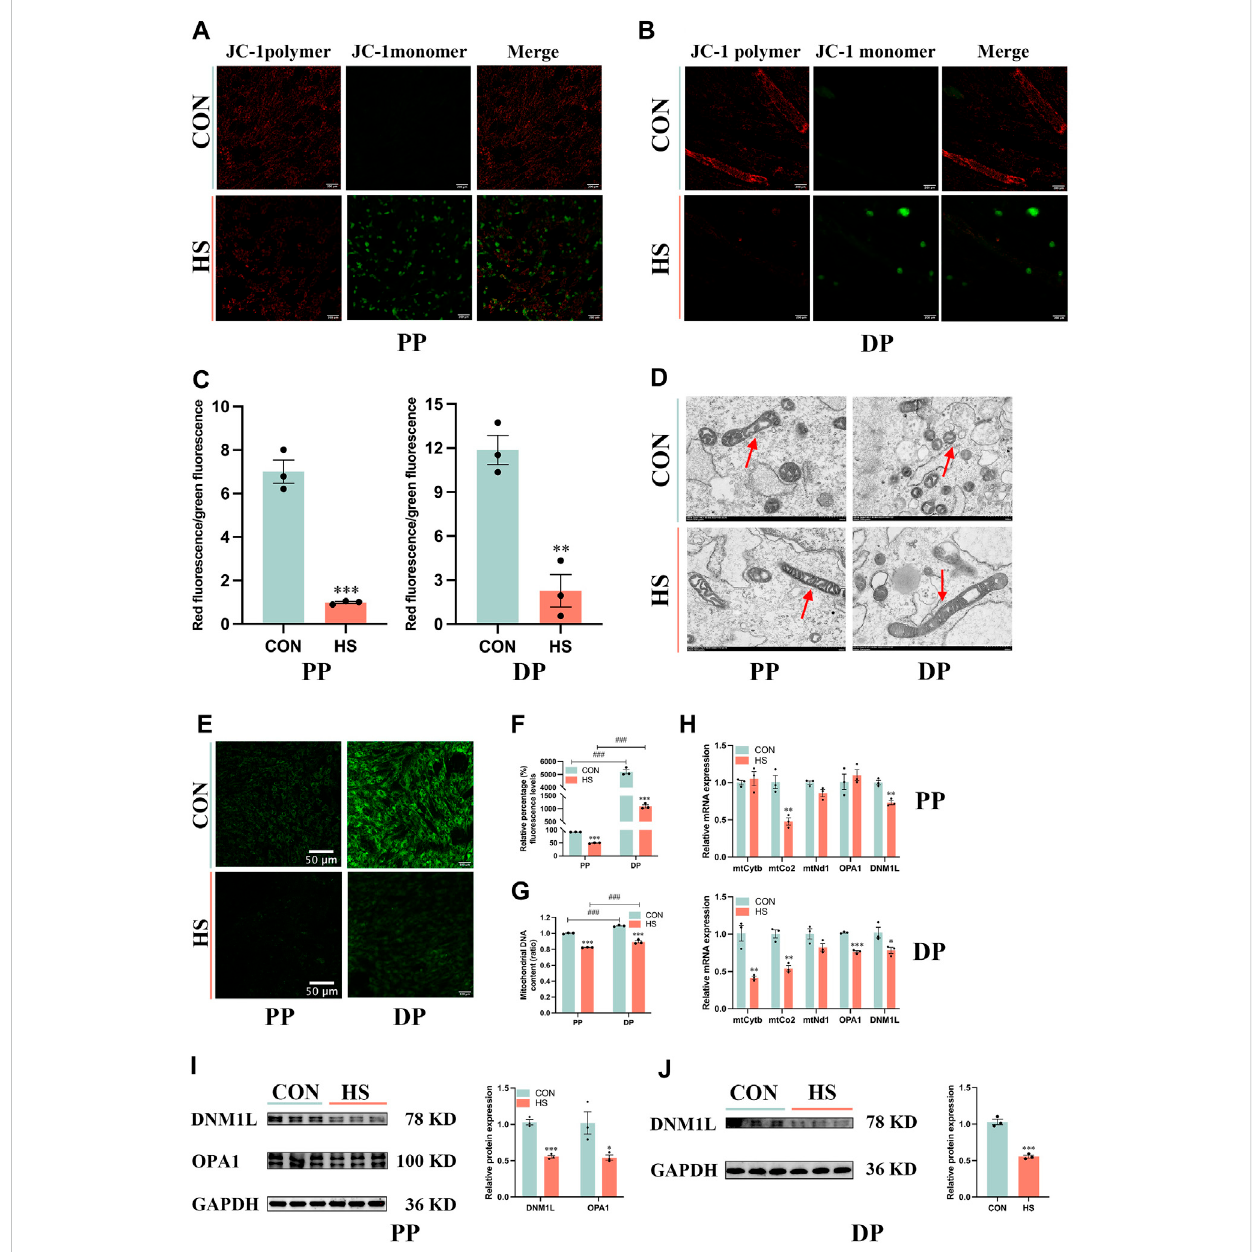
Heat stress impaired the mitochondrial biogenesis and function of myoblasts. Representative images of myoblasts stained by JC-1 during proliferation (A) and differentiation (B) . (C) The ratio of the red fl uorescence to the green fl uorescence. (D) Electron micrographs of myoblasts during proliferation and differentiation. Red arrowheads indicate mitochondria. Scale bar, 500 nm. (E) Representative images of myoblasts stained by Mito- Tracker Green probe during proliferation and differentiation. (F) The relative percentage of Mito-Tracker Green fl uorescence levels. (G) MitochondrialDNAcontentofmyoblasts atproliferationanddifferentiation. (H) mRNAexpressionofmitochondrialDNA-encodedgenesofmyoblasts at proliferationanddifferentiation.WesternblotanalysisoftheexpressionofDNM1LandOPA1inmyoblastsatproliferation (I) anddifferentiation (J) .Alldata are shown as the mean ± SEM (n = 3, * p < 0.05; ** p < 0.01, *** p < 0.01, and ### p < 0.001 compared with